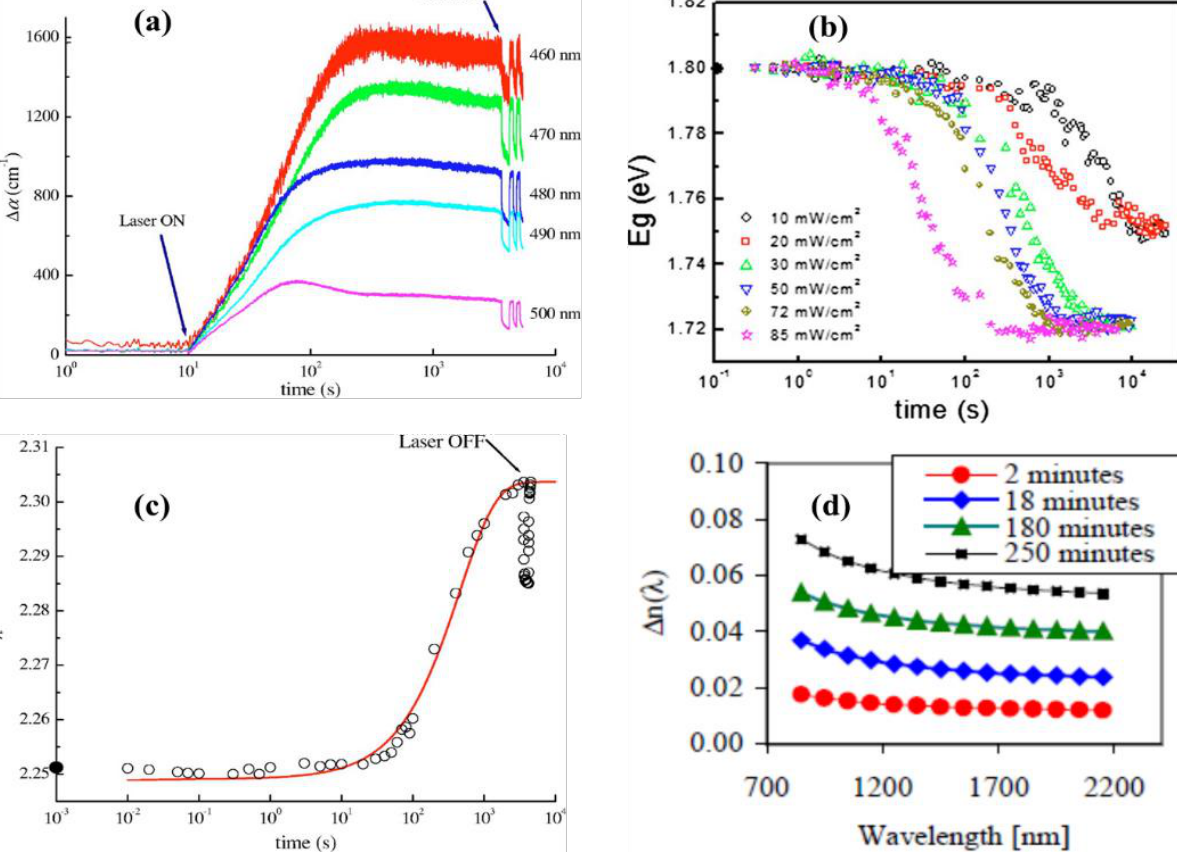
Figure 2. ( a ) Time evolution of absorption coefficient at wavelengths between laser ON and OFF states as indicated in the figure. All Figures are reprinted with permission from [13] Copyright 2006, American Physical Society. ( b ) Change in optical band gap ( E g ) at different laser intensities. The solid black circle depicts E g in the as-prepared state before switching on the exciting laser. All Figures are reprinted with permission from [26] Copyright 2009, American Institute of Physics. ( c ) Time evolution of refractive index ( n ) at 633 nm during and after illumination. The solid red line denotes the theoretical fit. The solid black circle indicates n in as-prepared state. All Figures are reprinted with permission from [13] Copyright 2006, American Physical Society. ( d ) Wavelength spectra of refractive index. All Figures are reprinted with permission from [27] Copyright 2002, The Optical